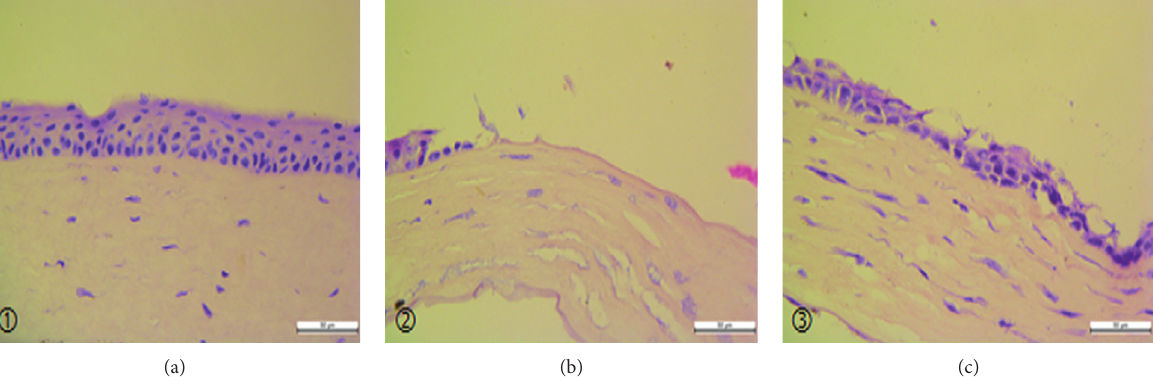
Figure 2: Hematoxylin-eosin staining in cornea. The results of corneal HE staining in the (a) control group, (b) saline group, and (c) pranoprofen group (x400 times, 50 μ m).